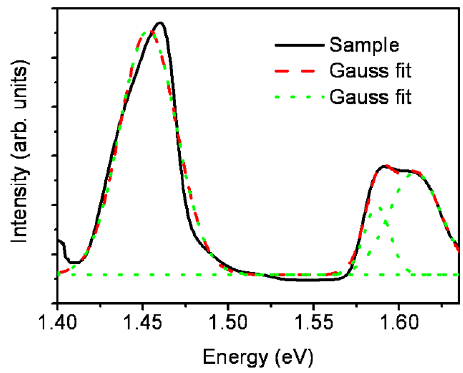
Figure 2. Typical photoluminescence (PL) spectrum of GaAs nanostructures deposited on a silicon substrate placed at a distance of 4.0 cm.